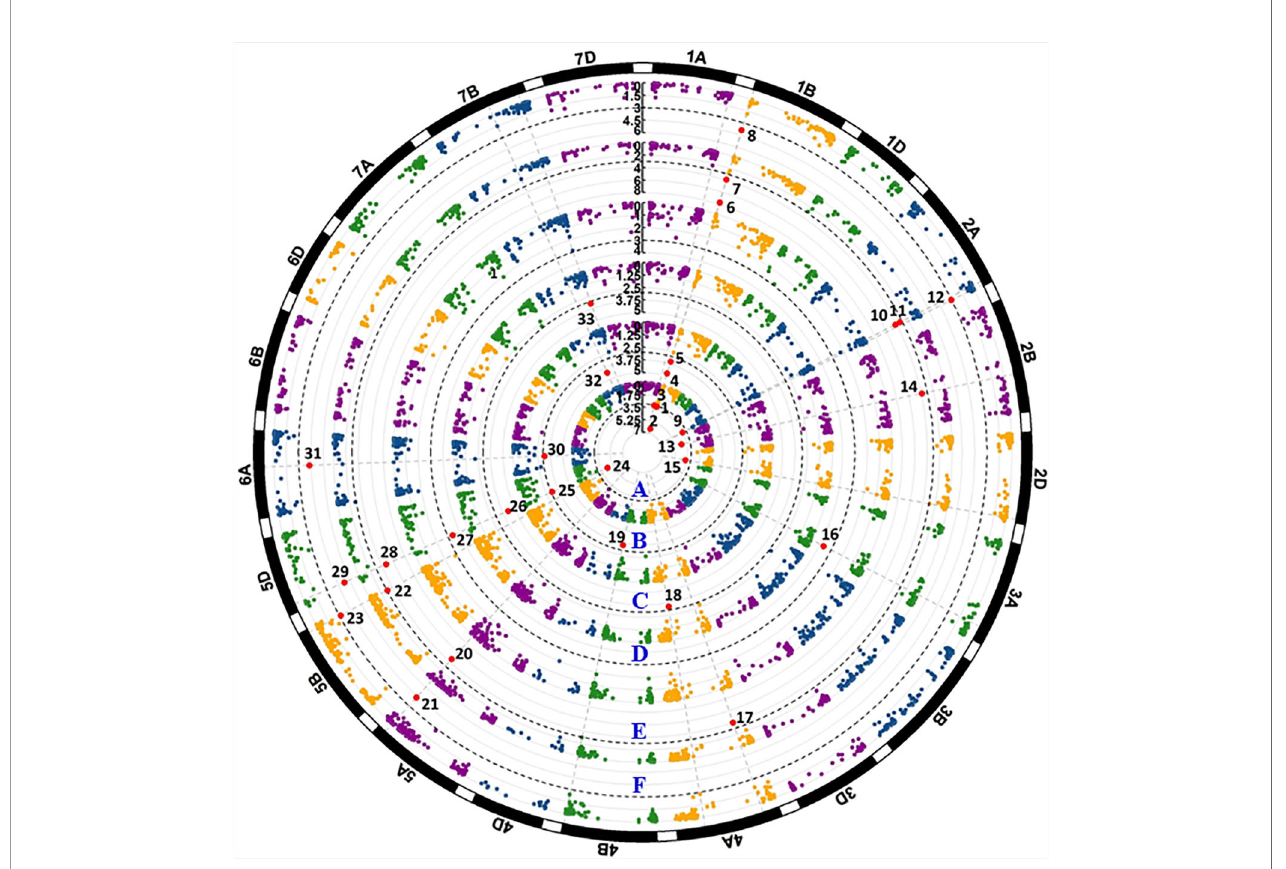
FIGURE 4 | Manhattan plots of signi fi cant p values for markers associated with all-stage resistance to stripe rust. The black dash line shows the threshold -log10(p) value of 3. Each circular represents one seedling test with race PSTv-4 (A) , PSTv-14 (B) , PSTv-37 (C) , PSTv-40 (D) , PSTv-51 (E) , and PSTv-198 (F) . Signi fi cant markers are enlarged in red dots and